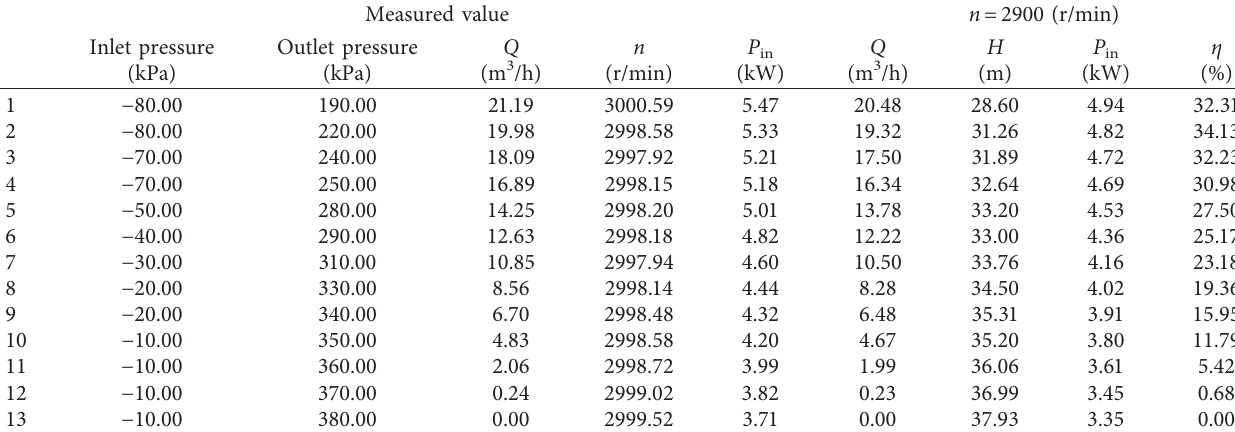
Table 5: Performance experiment of double arc method.